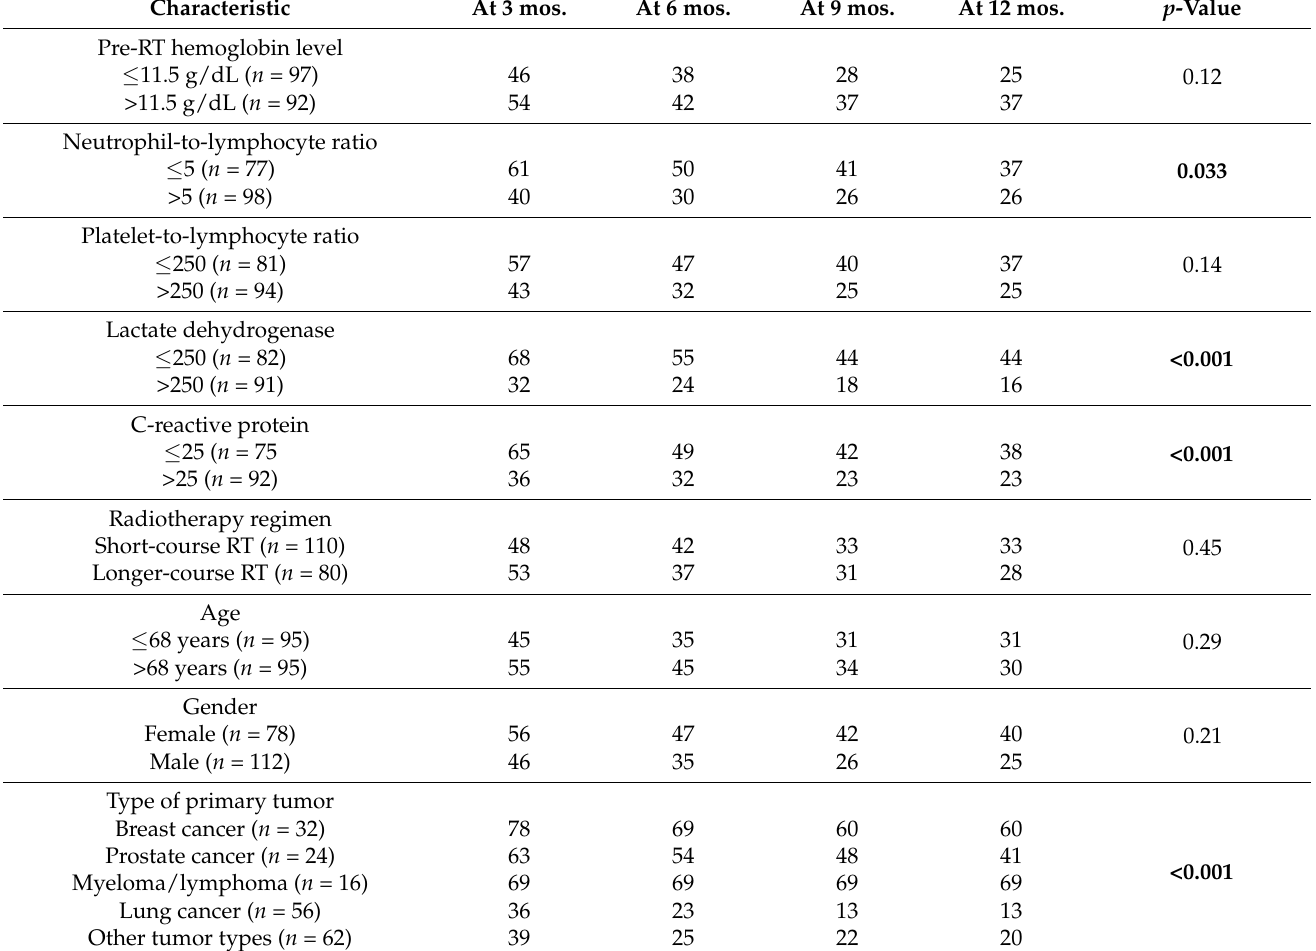
Table 1. Univariate analyses: Survival rates (in %) at 3, 6, 9, and 12 months following radiotherapy. Characteristic At 3 mos. At 6 mos. At 9